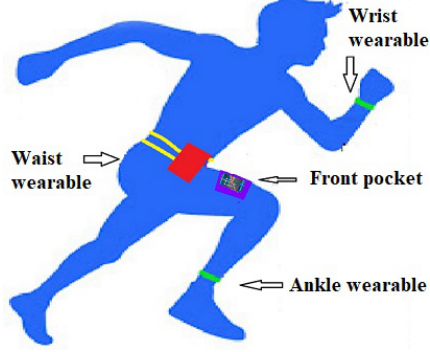
Fig 1. Wearable sensor locations on the body.